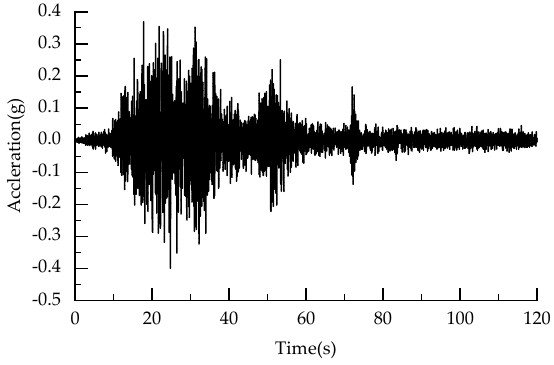
Figure 3. Input earthquake wave.